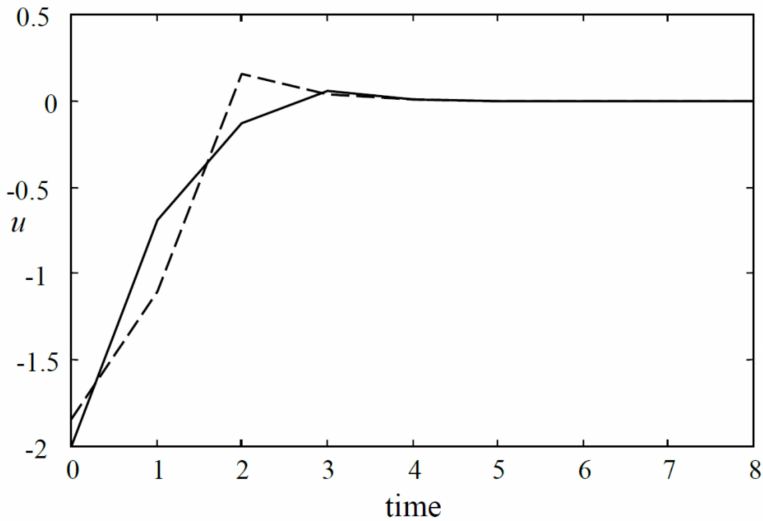
Figure 2. The input responses of the closed-loop system (dashed line for Algorithm 1, solid Algorithm